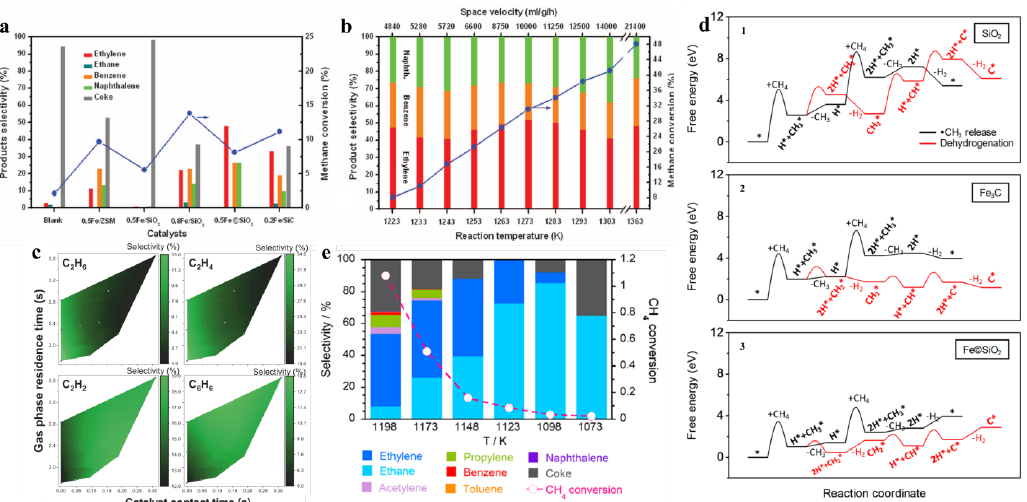
Figure 2. ( a ) Comparison of different catalysts at 1223 K [20], ( b ) effect of reaction temperatures and space velocities on the 0.5% Fe©SiO 2 catalyst. Blue circles denote CH 4 conversion, whereas bars rep- resent product selectivity, CH 4 conversion, and C 2 hydrocarbon selectivity over Fe©SiO 2 catalyst [20], copyright 2014, The American Association for the Advancement of Science. ( c ) C 2 H 6 , C 2 H 4 , C 2 H 2 , and C 6 H 6 selectivity as functions of catalyst contact time and gas-phase residence time. Exper- imental NOCM results using Fe@CRS catalyst in a fixed-bed reactor [22], copyright 2020, Springer Nature. ( d ) The activation energy barrier of CH 4 on SiO 2 , Fe 3 C, and Fe©SiO 2 catalysts [24], and ( e ) product distribution and CH 4 conversion on Ni-P/SiO 2 catalyst as a function of temperature [23].